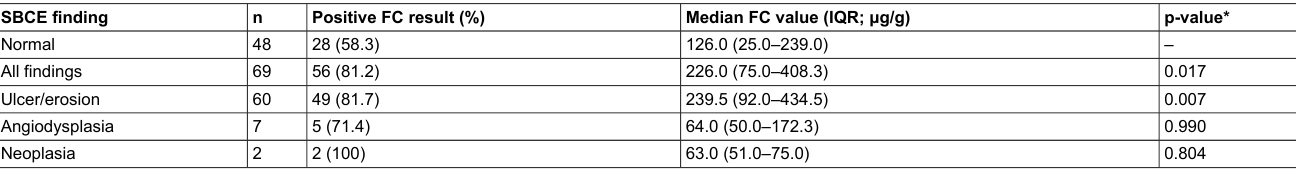
Table 4: Small bowel capsule endoscopy findings and faecal calprotectin values. SBCE